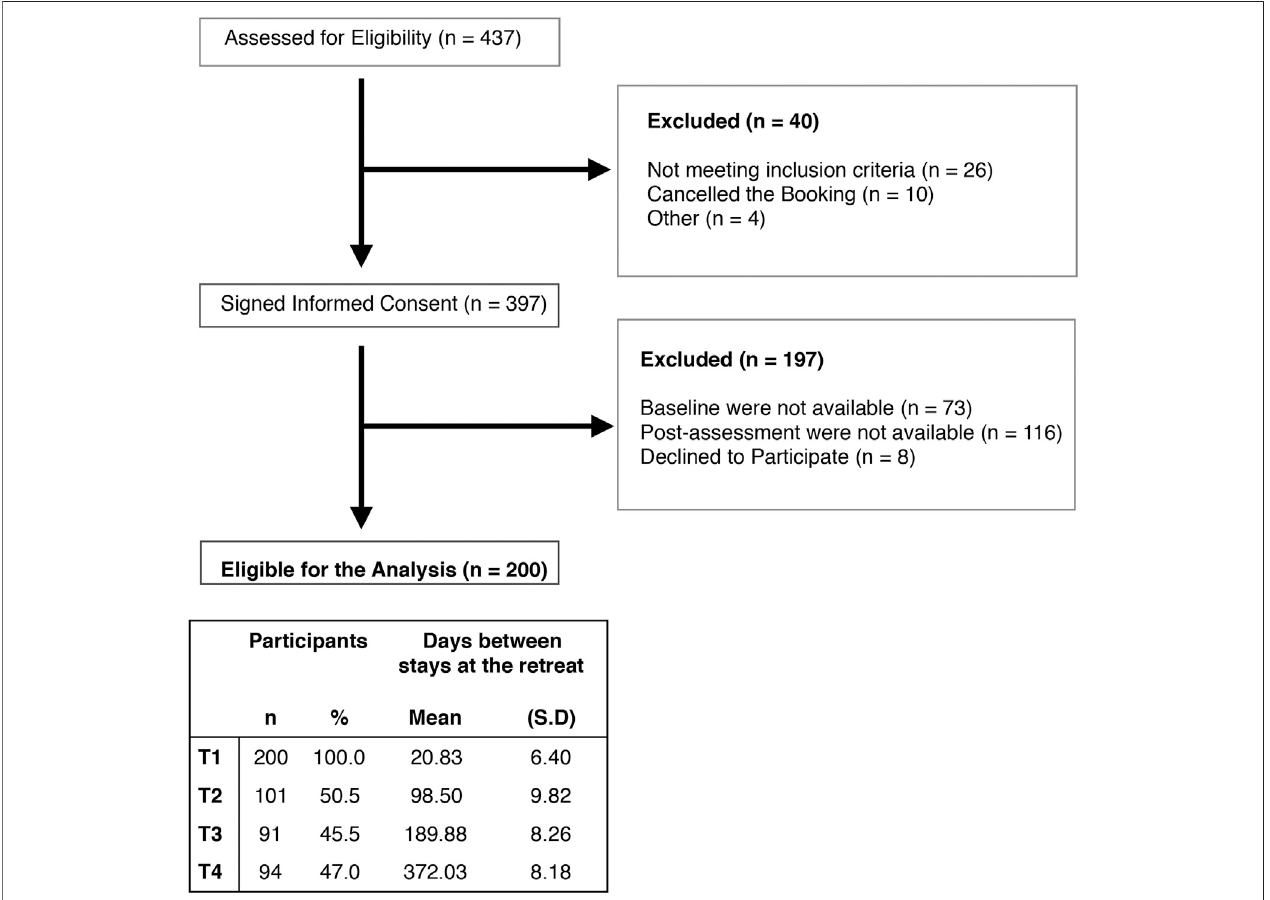
FIGURE 1 | Participant fl ow throughout the